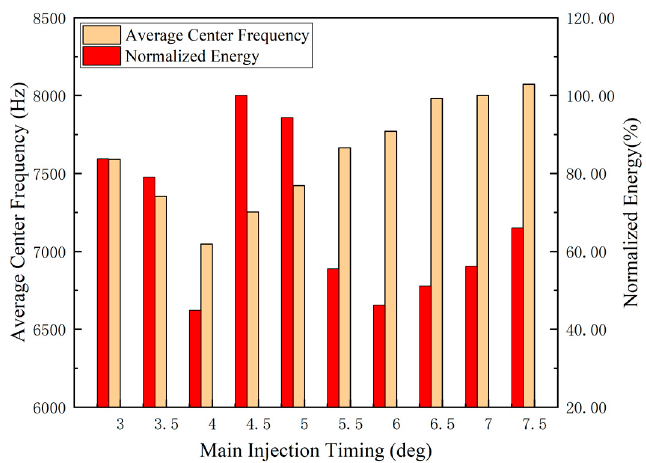
Figure 23. Average center oscillation frequency and the normalized average oscillation energy under di ff erent main injection timing.